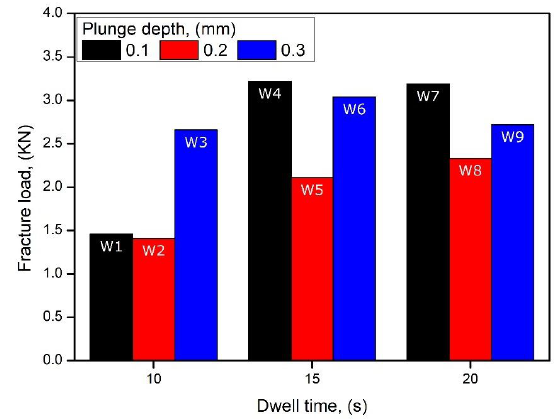
Figure 8: Tensile-shear load as a function of dwell time under differ- ent plunge depth for P-FSSW joints welded without Cu interlayer